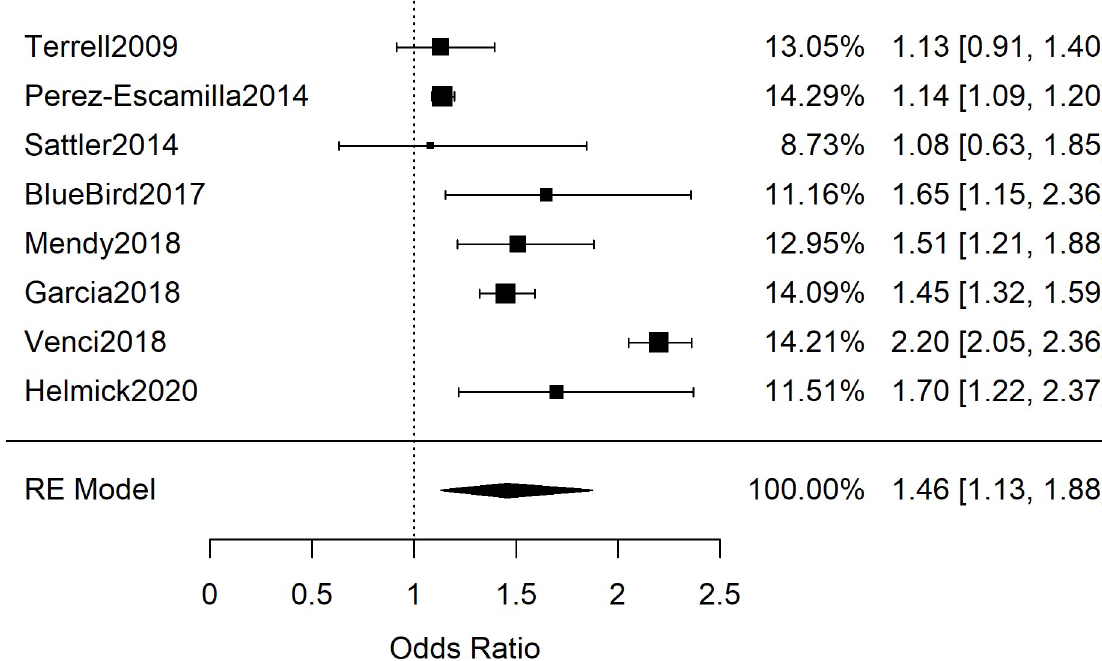
Fig 3. Meta-analysis of adult studies investigating food insecurity and self-reported hypertension. Presented are the adult odds ratio studies involving self-reported hypertension, demonstrating a significant, combined odds ratio of 1.46 [95%CI: 1.13, 1.88; n = 127,467; Q ( df = 7) = 235; I 2 = 97%].